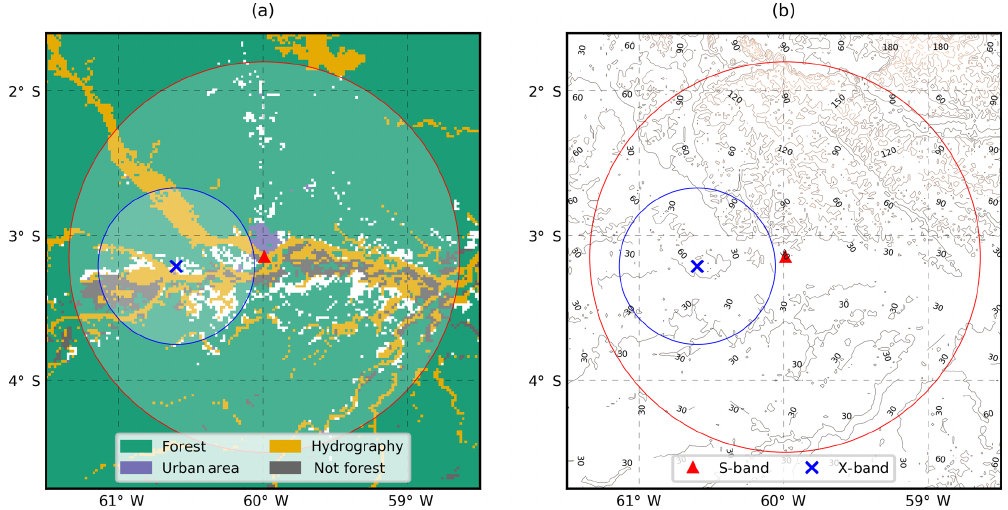
Figure 8. (a) Four vegetation classes as obtained from the digital Terra Class classification: forest, hydrography, non-forest, and urban area. (b) Topography across a 150km radius as derived using SIPAM radar. X-band (T3 site) and S-band radar positions are shown in the figure.